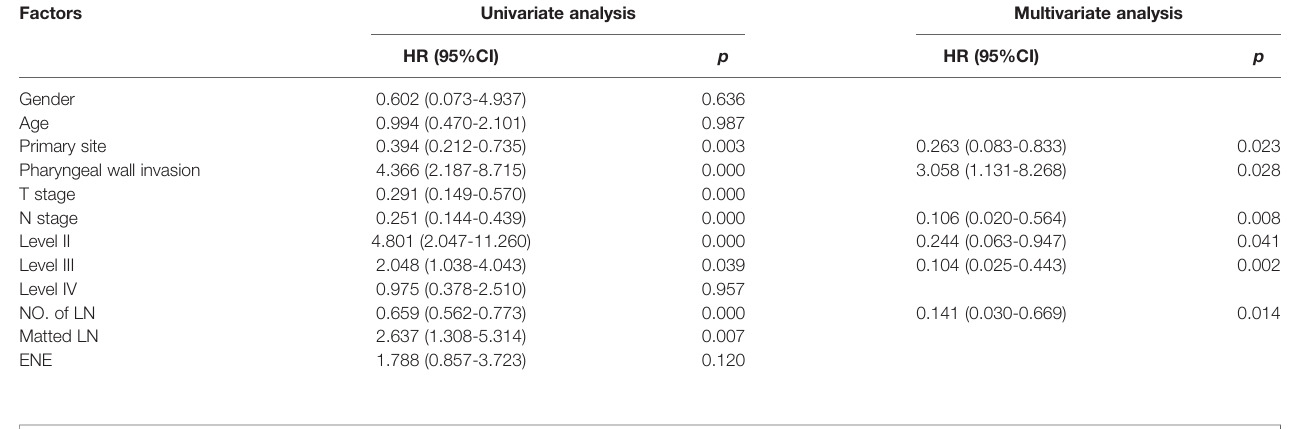
TABLE 2 | Risk factors associated with RPLN metastasis in univariate and multivariate analysis. Factors Univariate analysis